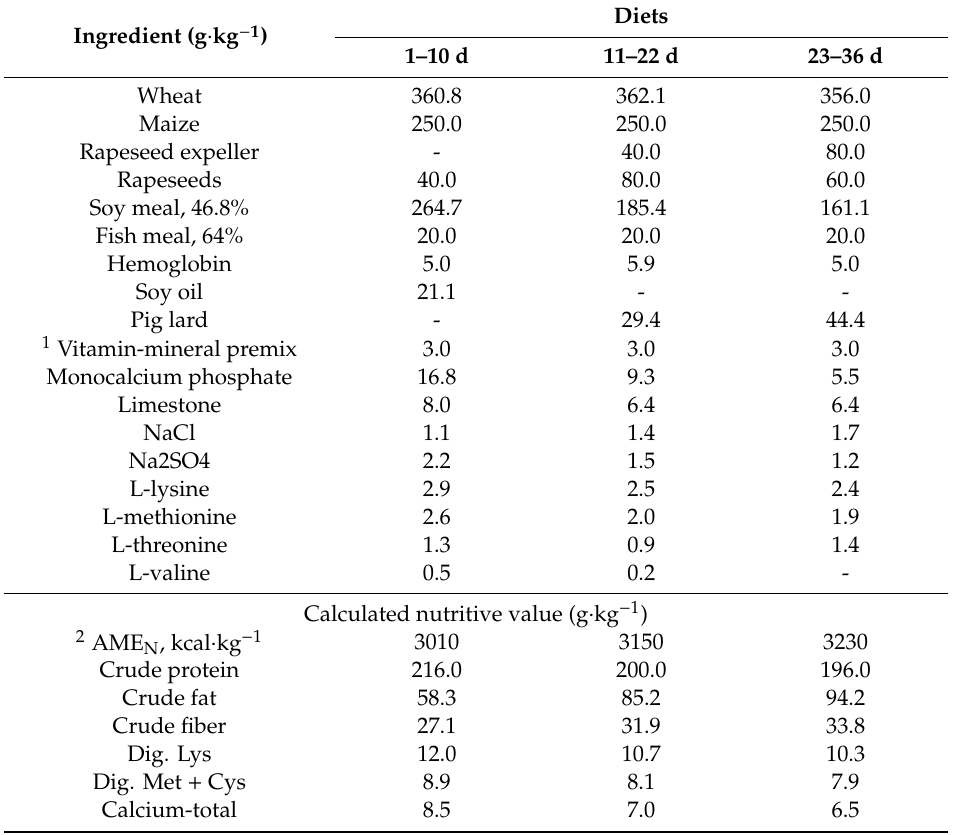
Table 1. Composition and nutritive value of the basal